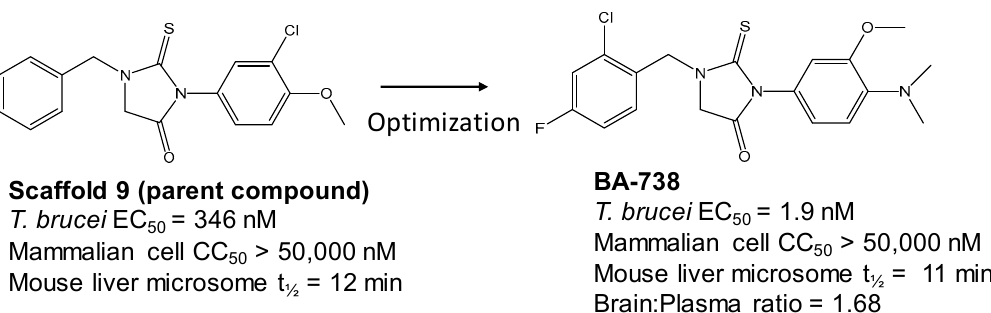
Figure 5. Sca ff old 9: Optimization of hit “thiohydantoin” compound to lead compound Figure 5. Scaffold 9: Optimization of hit “thiohydantoin” compound to lead compound BA-738.